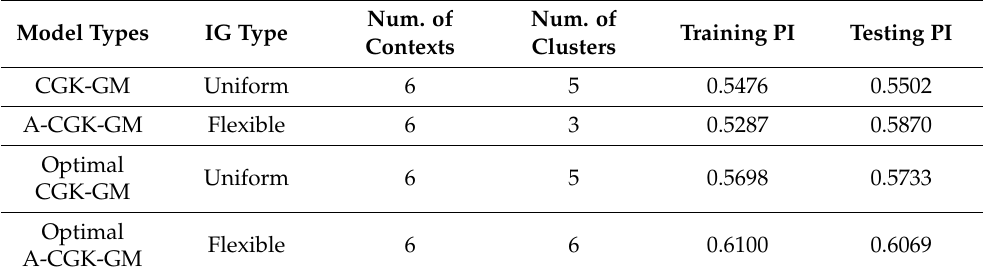
Table 10. Result of Boston House Prices prediction